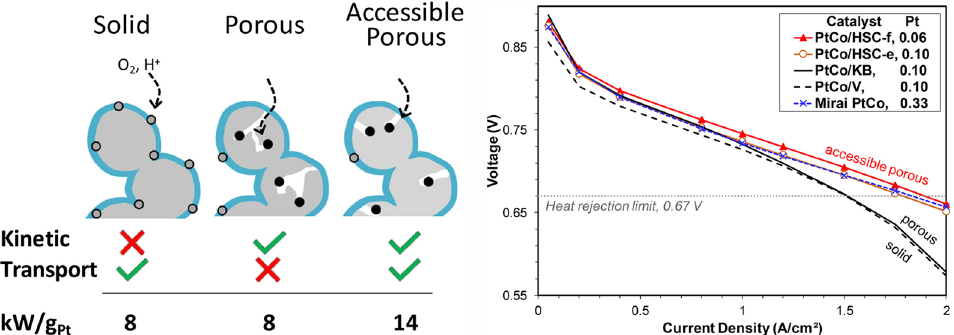
Fig. 17. – Yarlagadda et al. report on how different types for pore structures in carbon materials influence catalyst activity. Black cycles denote active, grey cycles denote less active nanoparti- cles, blue denotes adsorption of ionomer on the support material. The panel on the right shows how increased activity is obtained when accessible pores are available. Figure reproduced with permission from